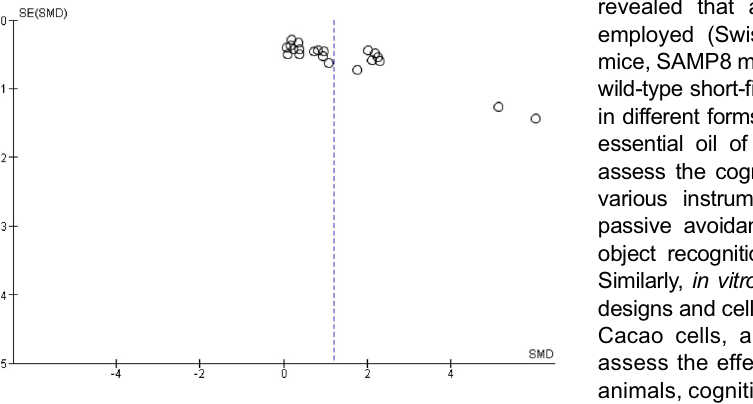
Figure 6. Funnel plot of experimental comparisons on normal rodents (maximal dosages only, different tasks shown sepa- rately). SMD, standardized mean